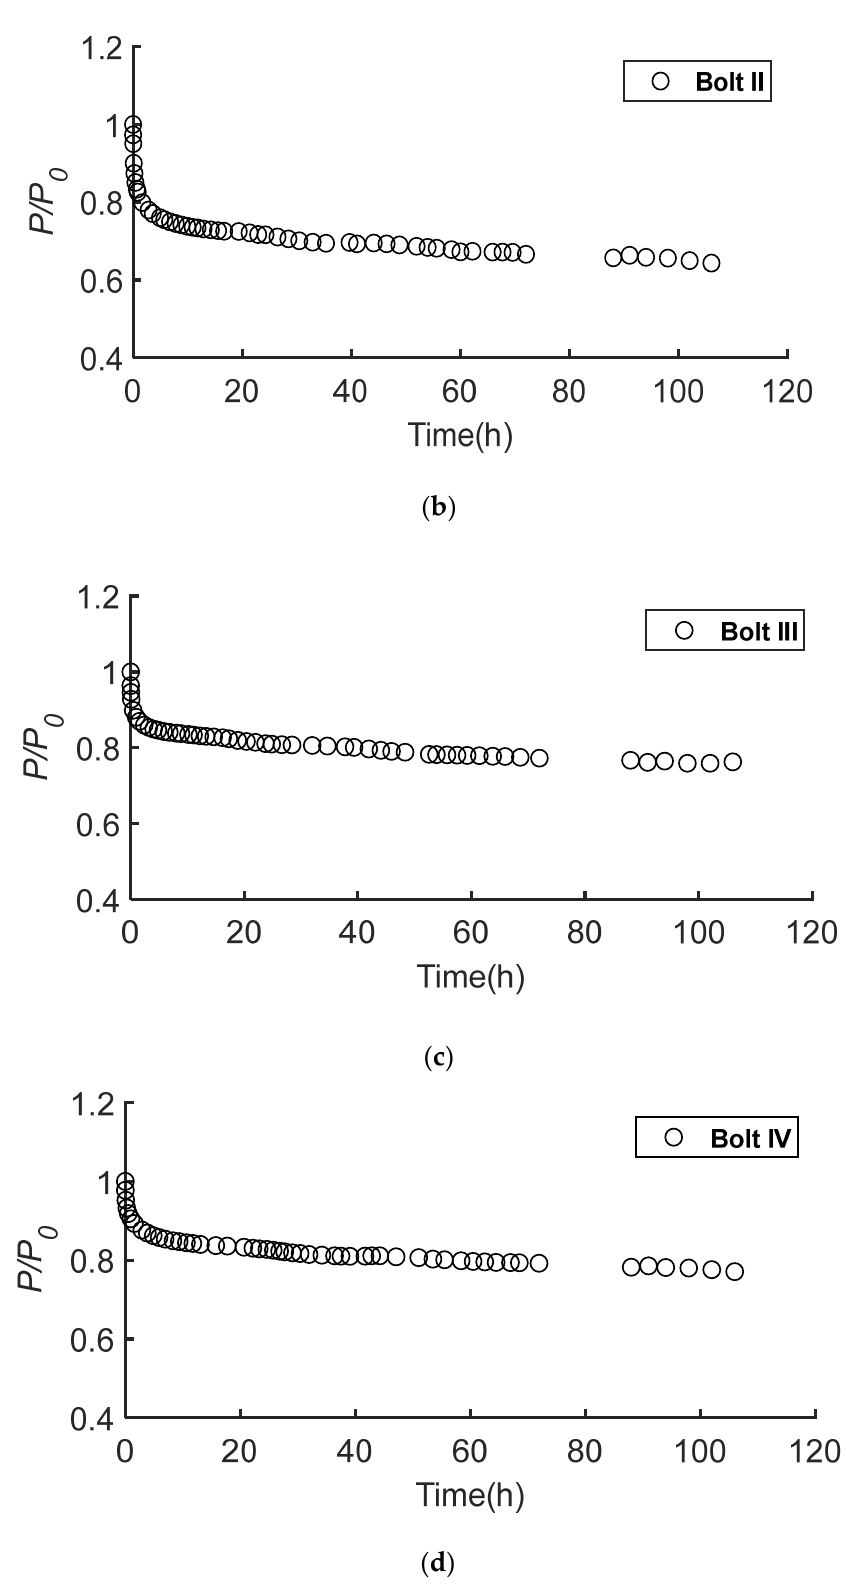
Figure 12. Stress relaxation of high-strength bolts. ( a ) Bolt I; ( b ) Bolt II; ( c ) Bolt III; ( d ) Bolt IV. Table 5. Stress relaxation of high-strength bolts in real-time.